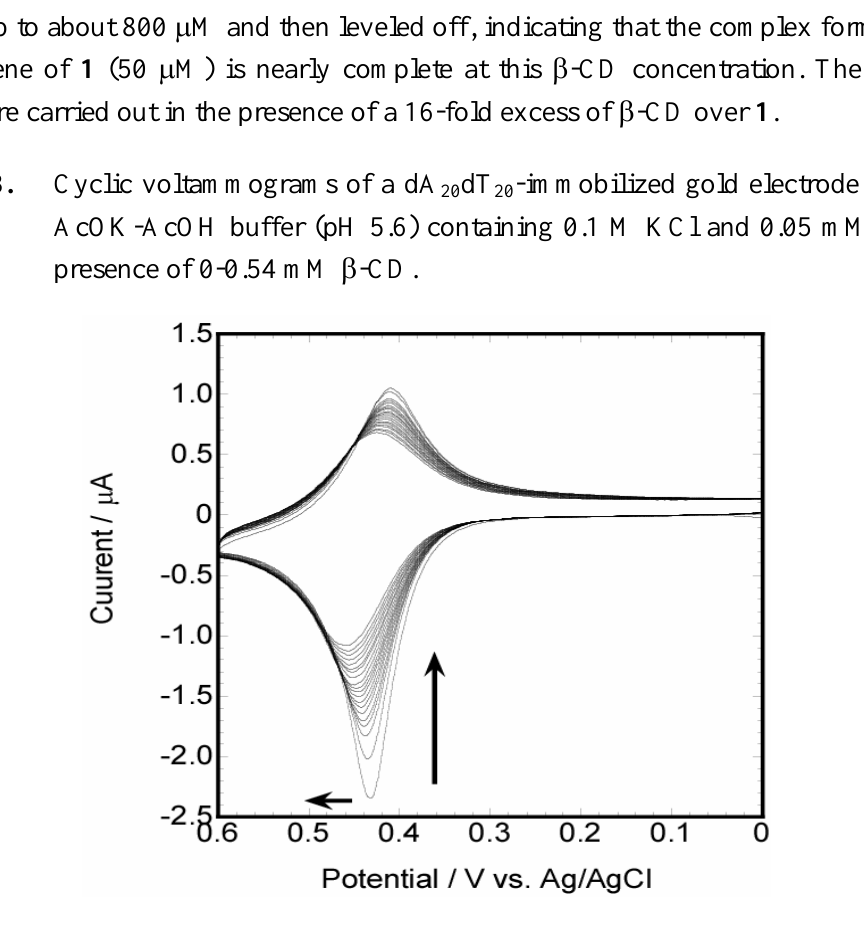
dT -immobilized gold electrode in 0.1 M 20 20